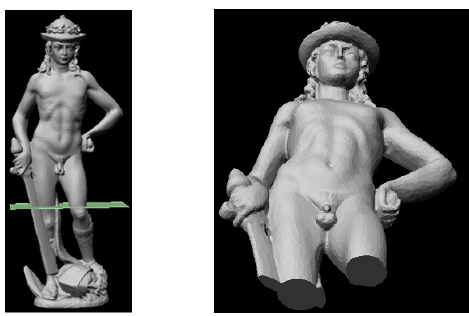
Figure 14. The “cut by plane” mode in Polyworks